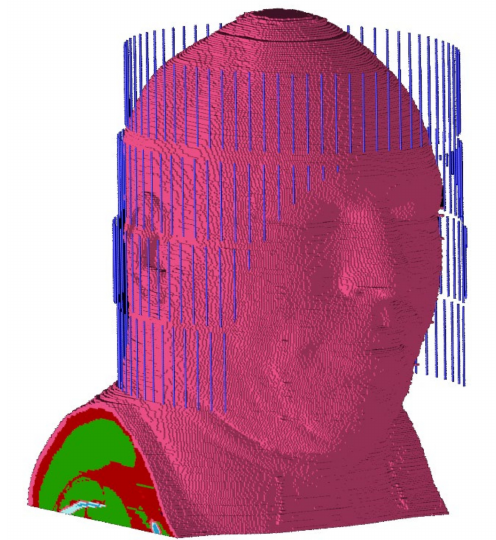
Figure 8. Model of head with wire